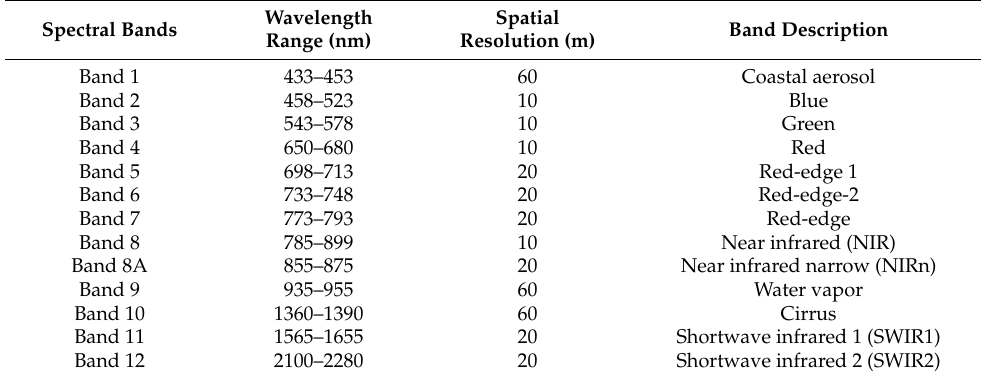
Table 1. Spectral bands of the Sentinel-2 satellite imagery.